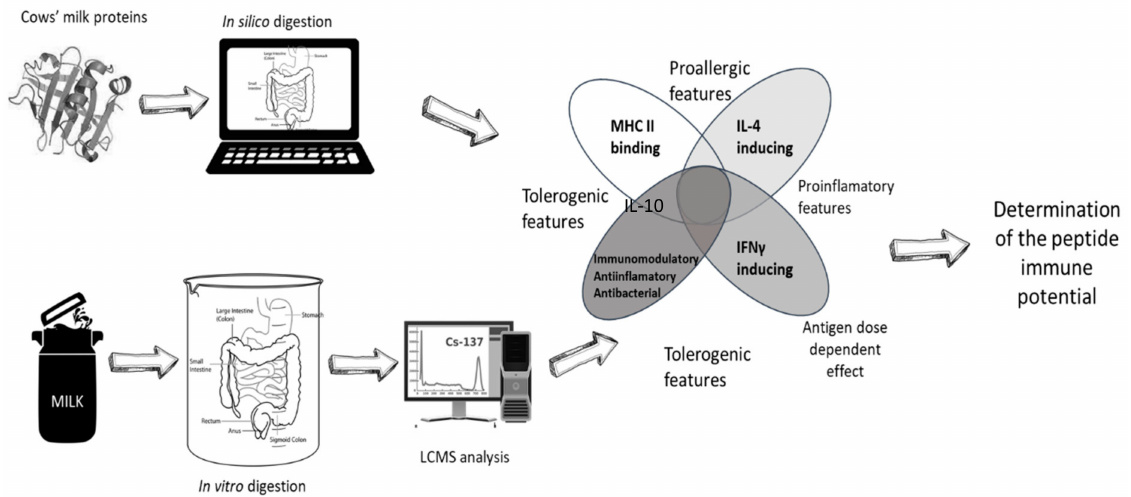
Figure 1. Scheme of in silico ( IS ) and integrated in vitro / in silico ( IV/IS )